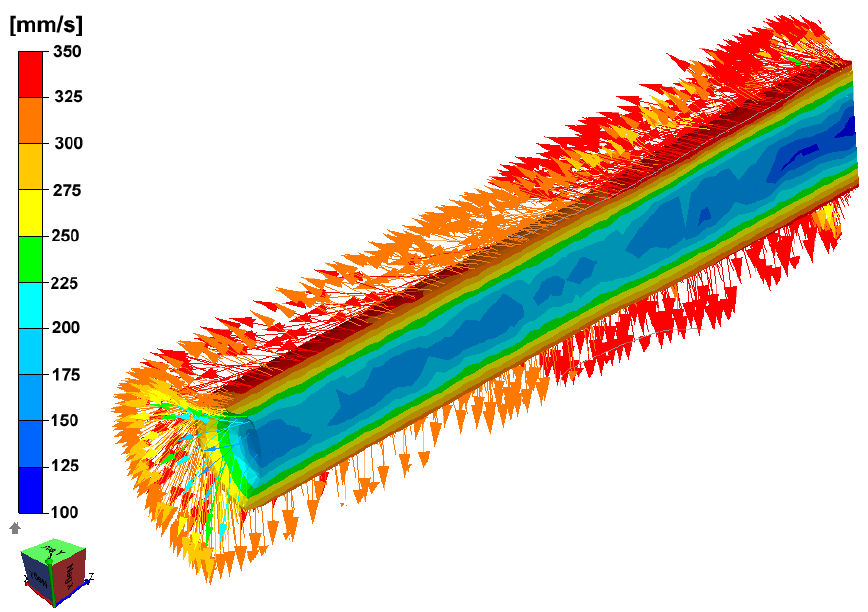
Figure 5. Distribution of metal flow velocity and vectors flow directions for the rolling process of AZ31 alloy bars (Variant I-pass no. 6).